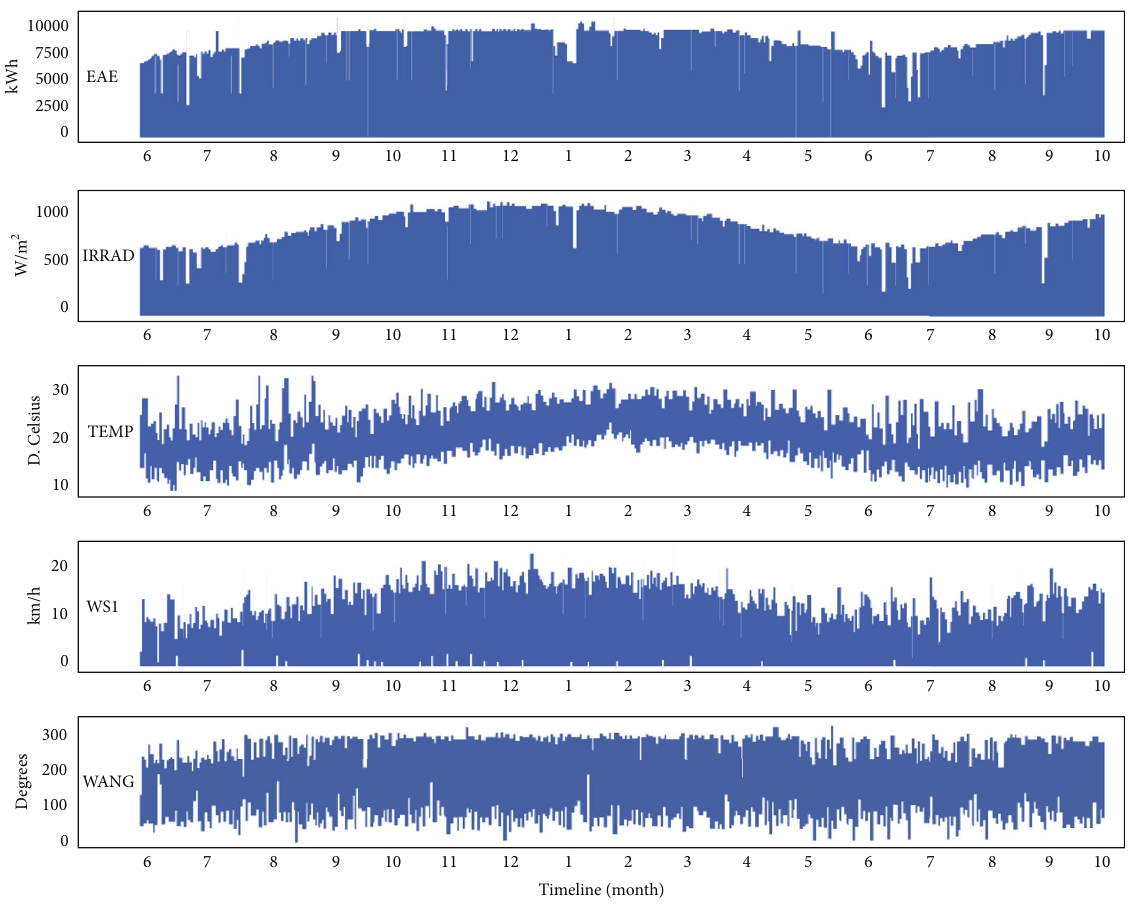
Figure 7: Behavior of all the variables